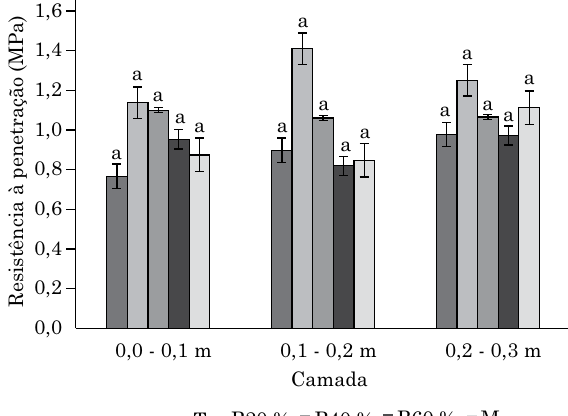
Figura 5. Resistência do solo à penetração, com os erros da média, para as áreas sob cultivo de figo e mata secundária (T - Testemunha; B20 % - Biofertilizante 20 %; B40 % - Biofertilizante 40 %; B60 % - Biofertilizante 60 %; e M - Mata nativa). médias seguidas pela mesma letra na camada não diferem pelo teste de Dunnett